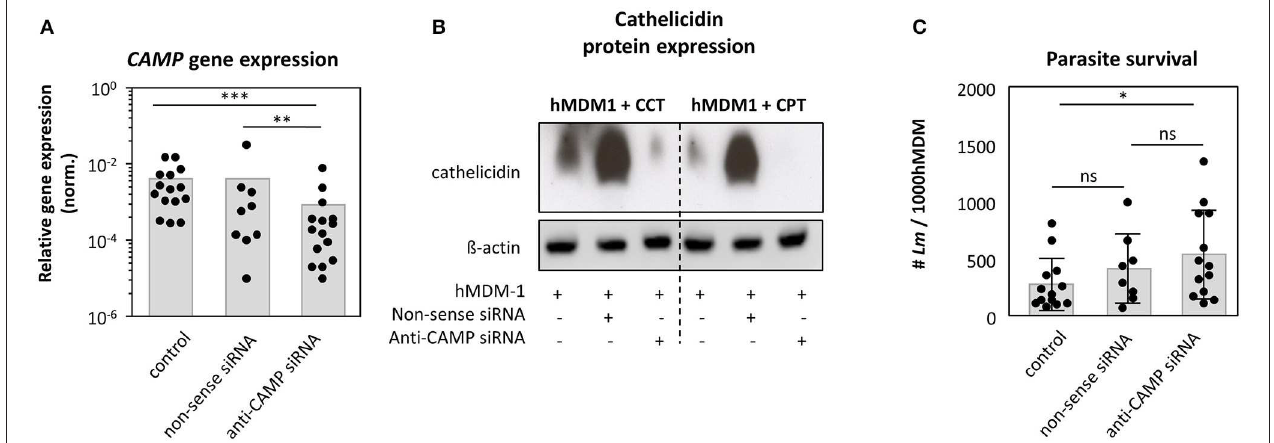
FIGURE 5 | Knockdown of CAMP in human primary macrophages promotes Leishmania infection. Human pro-inflammatory macrophages, hMDM-1, were treated with non-sense or anti-CAMP siRNA for 7h. After 2 d cells were harvested and CAMP gene expression and protein expression was assessed by qRT-PCR ( n = 9–15) (A) and western blot upon inducing cathelicidin expression using calcitriol (CCT) or calcipotriol (CPT) (B) . CAMP expression was normalized against the house keeping gene GAPHD . Western blots were analyzed by densitometry (ImageJ analysis), normalizing cathelicidin against ß-actin protein expression. (C) Subsequently, cells were infected with Lm (MOI10) for 48h followed by an end-point titration assay (see methods) to assess parasite survival ( n = 8–13). Data are presented as mean ± SD and are representative for at least 3 independent experiments (Wilcoxon matched-pairs signed rank test; * p < 0.05; ** p < 0.01; *** p < 0.001; ns, not